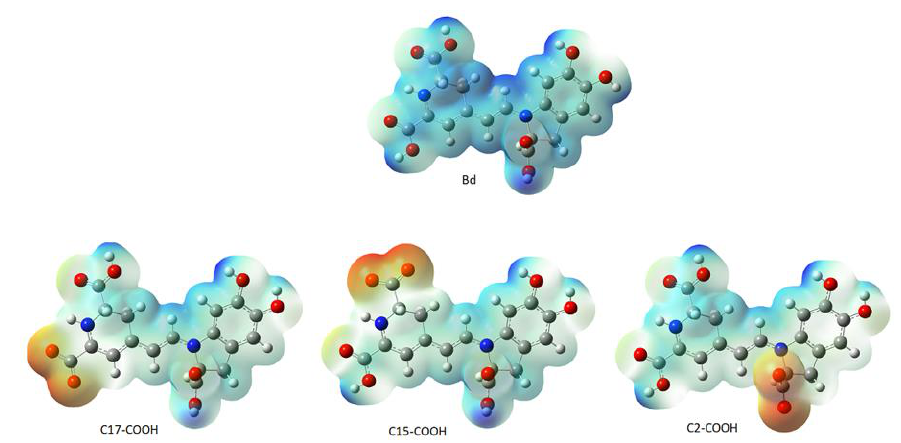
Figure 5. Electrostatic potential surfaces of Bd and zwitterionic forms.